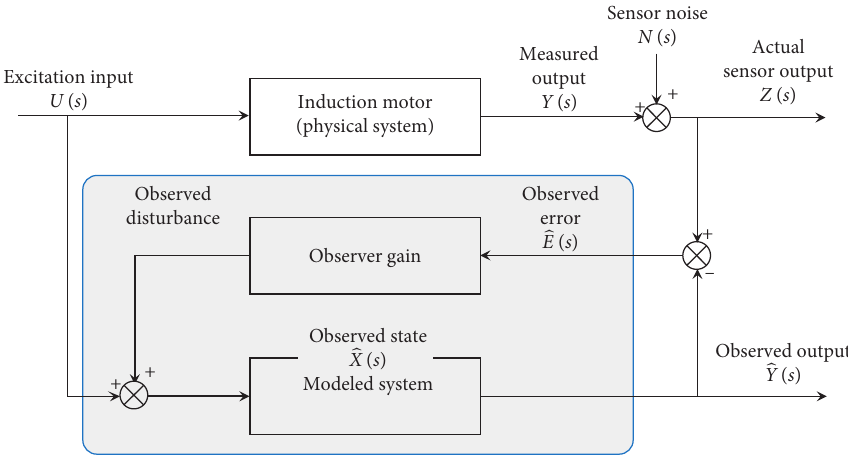
Figure 4: Structure of the full-order Luenberger observer in the presence of sensor noise.